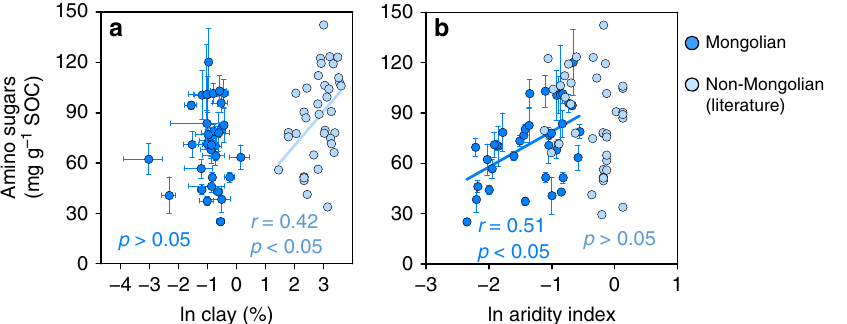
Fig. 6 Variations of amino sugar concentrations in different soils. Pearson correlation with clay contents ( a ) and aridity index ( b ) in the Mongolian ( n = 38) and non-Mongolian grassland soils ( n = 38). SOC, soil organic carbon. Error bars represent s.e.m. for three site replicates in the Mongolian grasslands. Data for non-Mongolian soils are derived from the literature 14,20,24,25 , which uses a different clay measurement method from the Mongolian